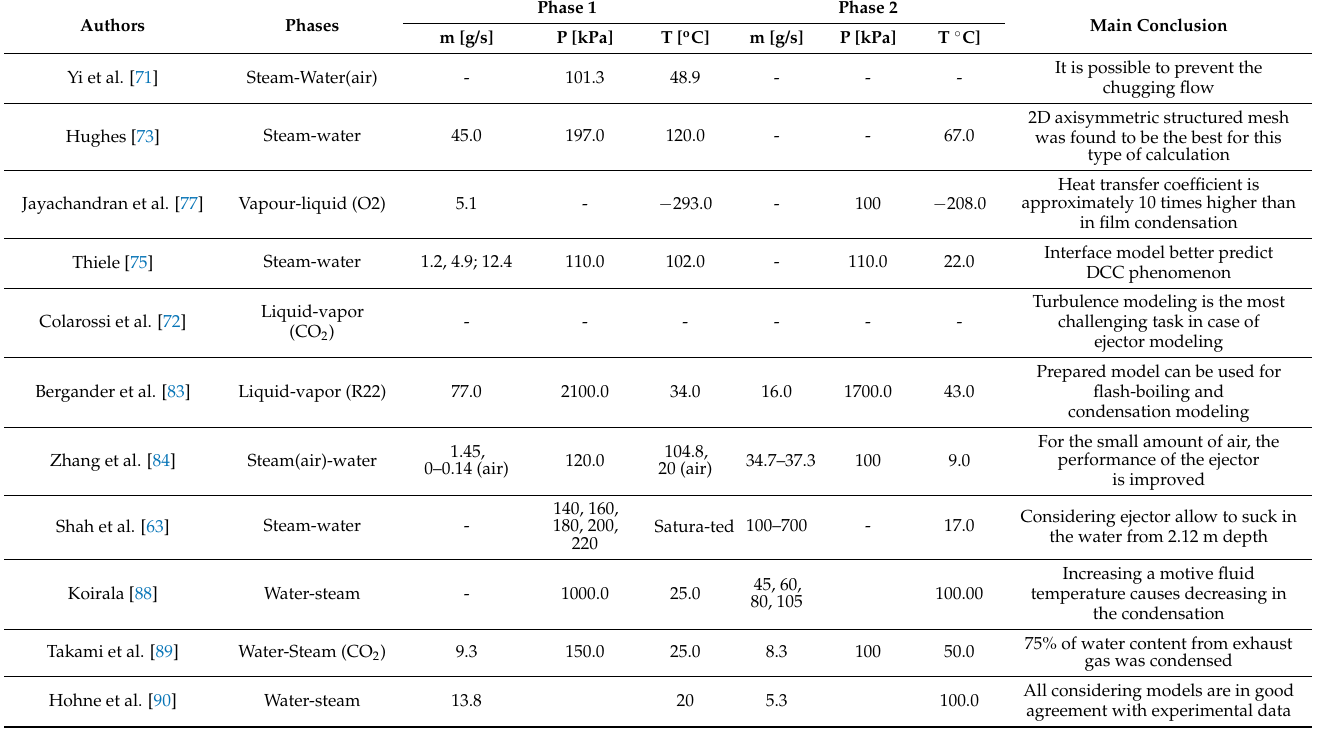
Table 26. Overview of direct contact condensation simulation